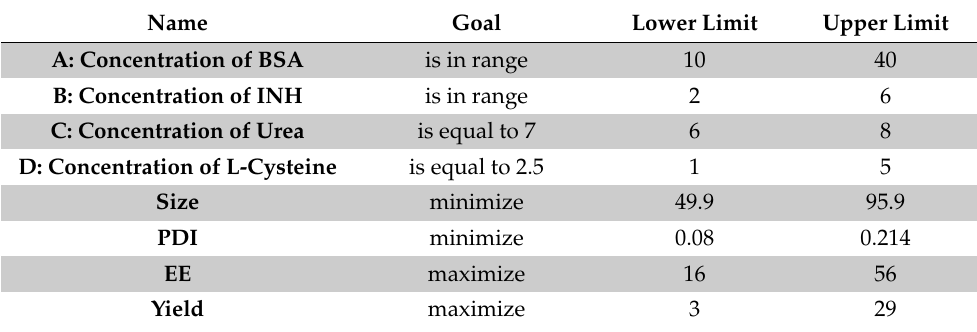
Table 7. Constraints of independent variables and